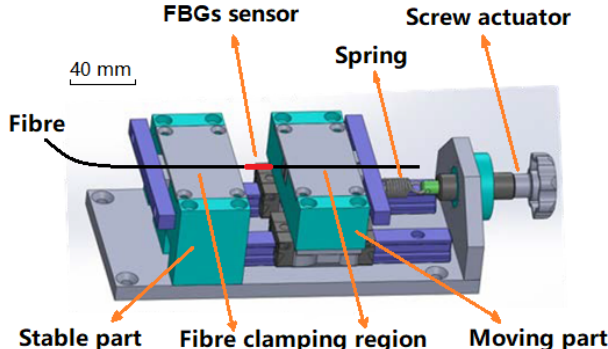
Figure 1. Initial loading assembly design.